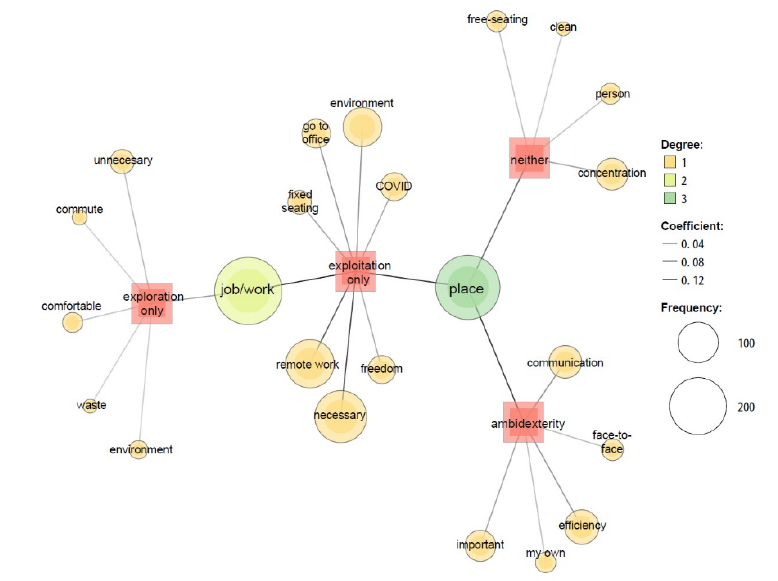
Figure 2. Co-occurrence network by